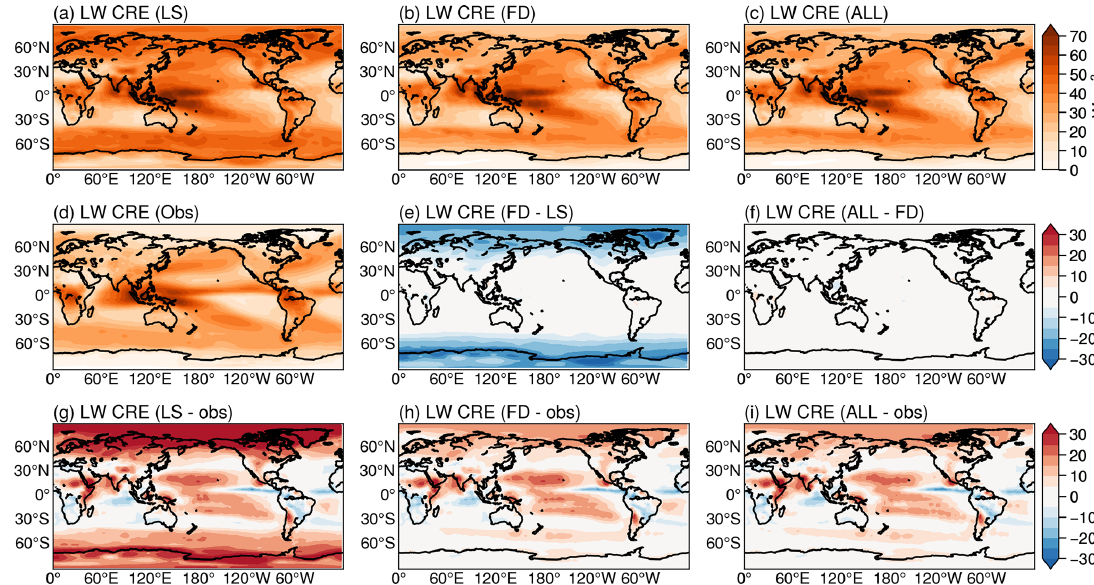
Figure 12. The same as in Fig. 10 but for LW CRE (Wm − 2 ) at TOA.